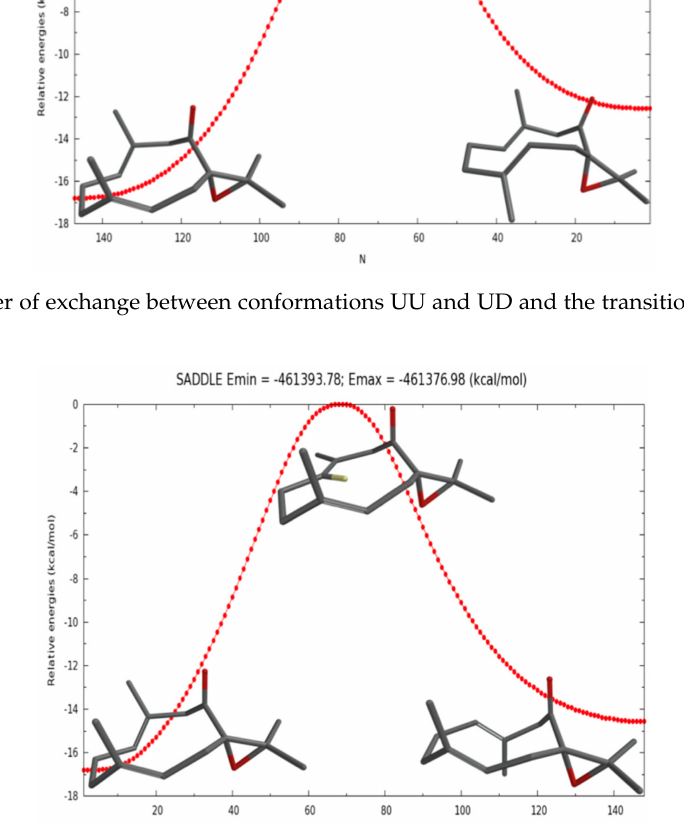
Figure 5. Barrier of exchange between conformations UU and DU and the transition state between both of them.